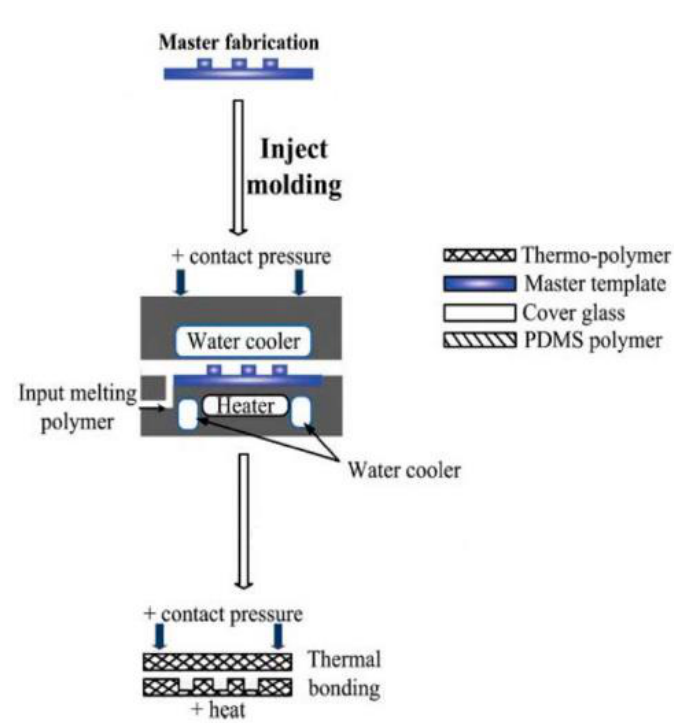
Figure 6. An example of a bioprinting setup (reprinted with permission from Liu et al.; copyright (2016) [99]). The design of a “digitally tunable continuous multi-material extrusion bioprinter” consisting of a “seven-channel printhead connected to reservoirs that are individually actuated by programmable pneumatic valves” [99].